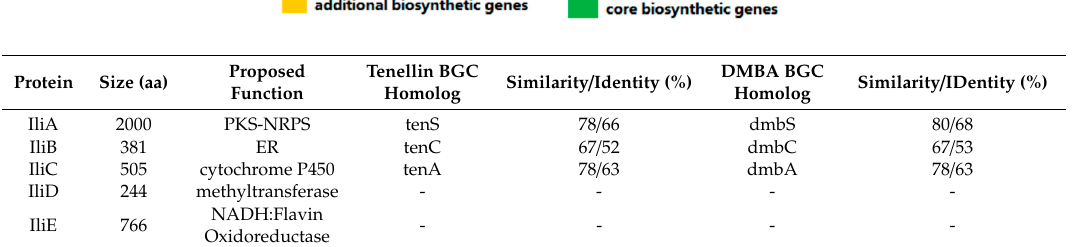
Figure 2. Putative biosynthetic gene cluster of ilicicolin H.